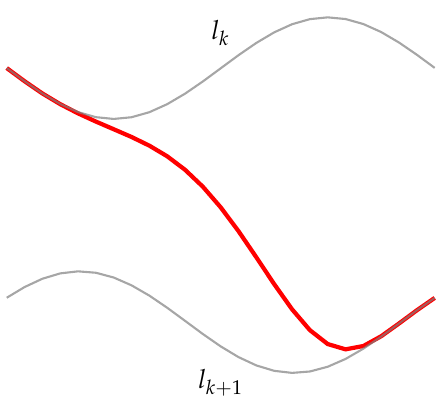
Figure 1. Two local curves ( l k and l k + 1 ) blended together to create a blending spline (red curve).